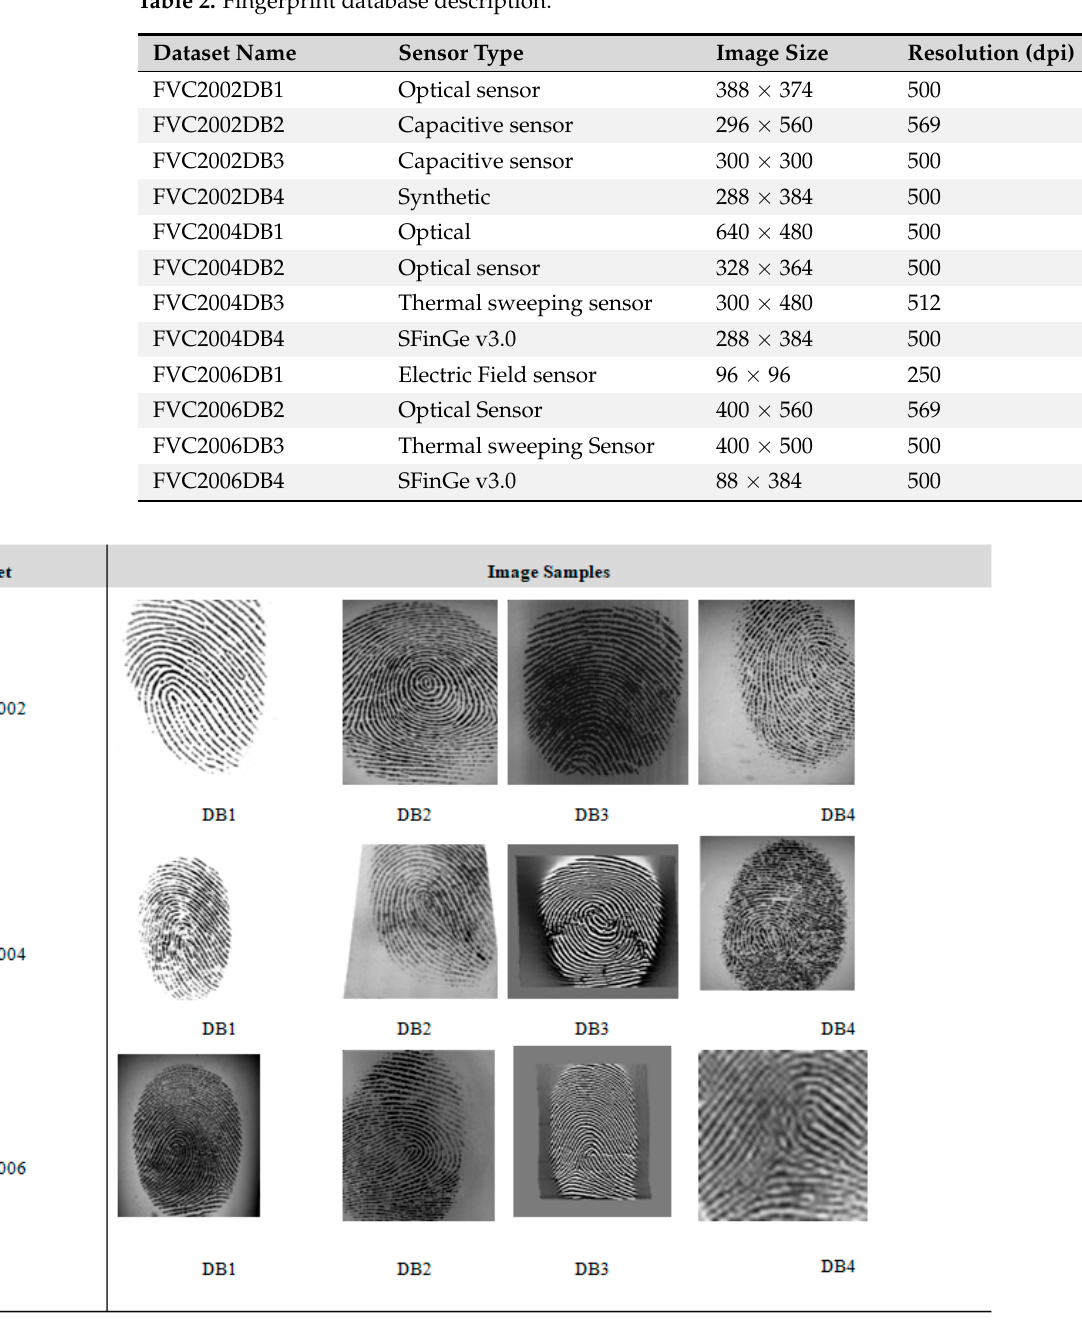
Figure 10. Fingerprint database samples.